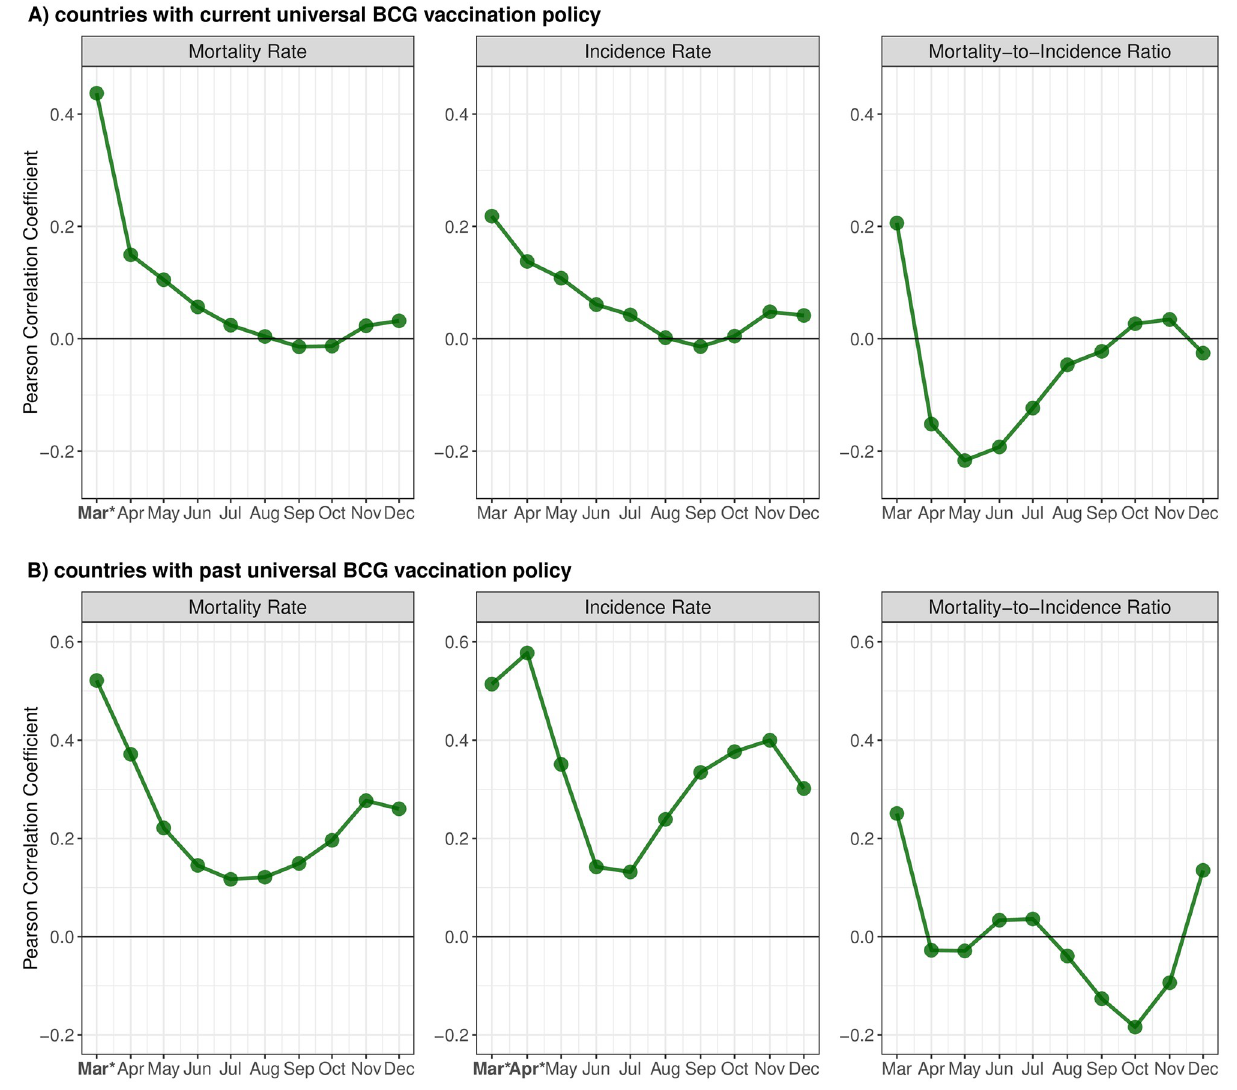
Fig 2. Pearson correlation coefficients between years of implementation of BCG Policy and COVID-19 outcomes among countries with current universal BCG vaccination policy (A) and among countries that previously had universal BCG vaccination policies (B), March-December, 2020. � Statistically significant Pearson correlation at p <